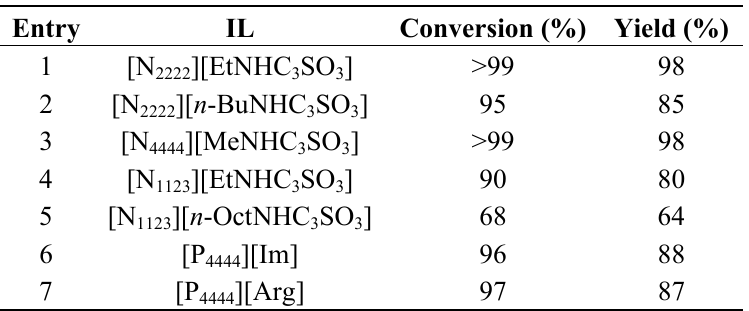
Table 2. Model aldol reactions in different functionalized IL catalytic systems. Reaction conditions: 3.4 mmol ILs, 50 wt % of H O of catalytic systems, 2.5 mmol benzaldehyde, 2